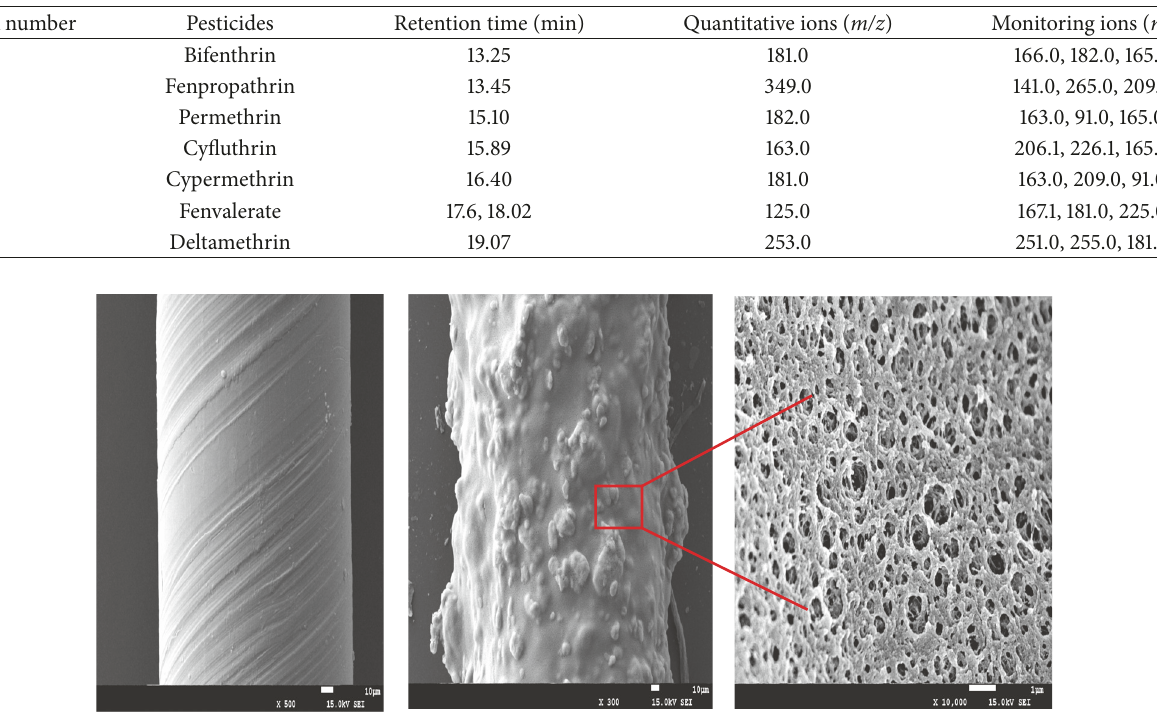
Table 1: The retention time, monitoring ions, and quantitative ions of 7 pyrethroids.